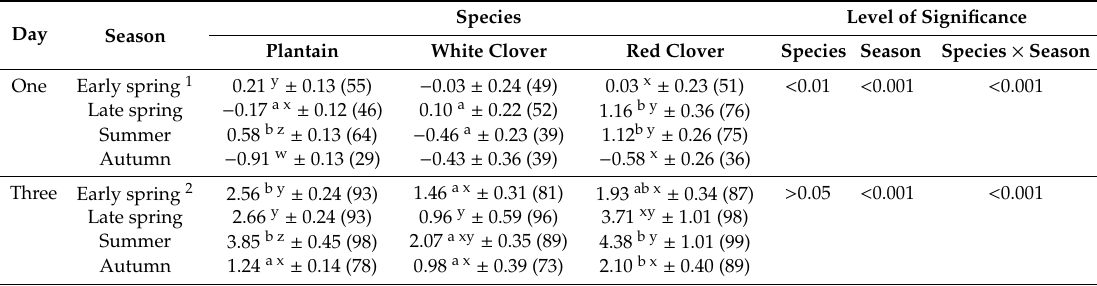
Table 4. Proportional selection by the plantain mix lambs of a tagged species, plantain, white clover and red clover, on day one and three during di ff erent seasons (logit lsmeans ± SEM, back transformed percentages (%) are given in